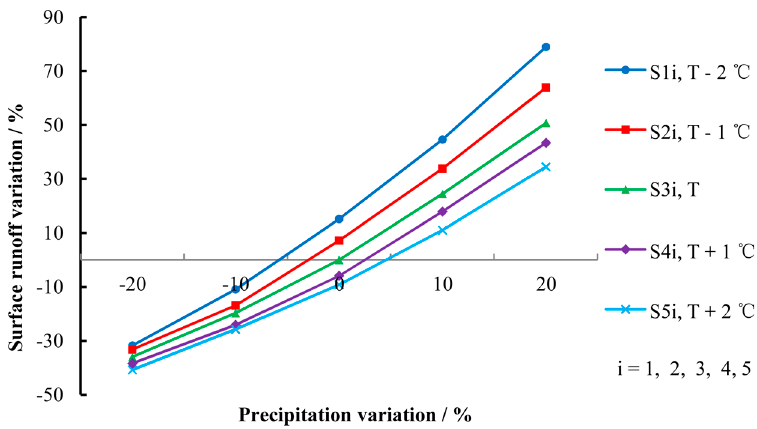
Figure 8. Rate of annual surface runoff change from base and other scenarios.